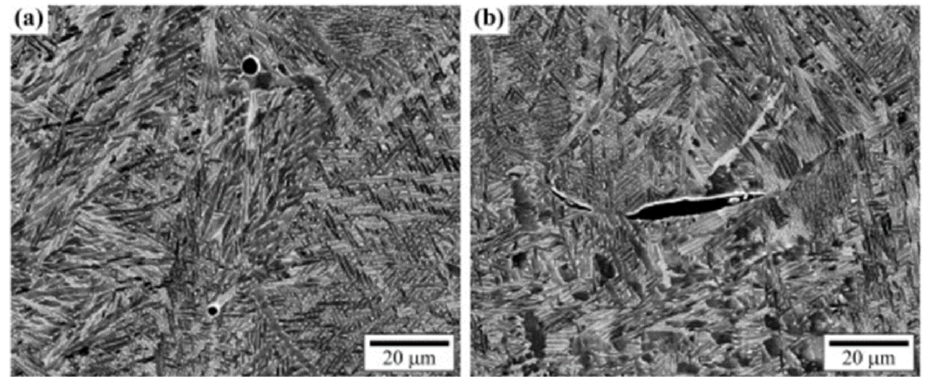
Figure 16. Examples of typical pores seen in SEBM deposits imaged by SEM (backscatter mode) in the x–z plane: ( a ) two circular pores and ( b ) a more irregular lack of fusion pore. The build direction is vertically upwards in the plane of the page.